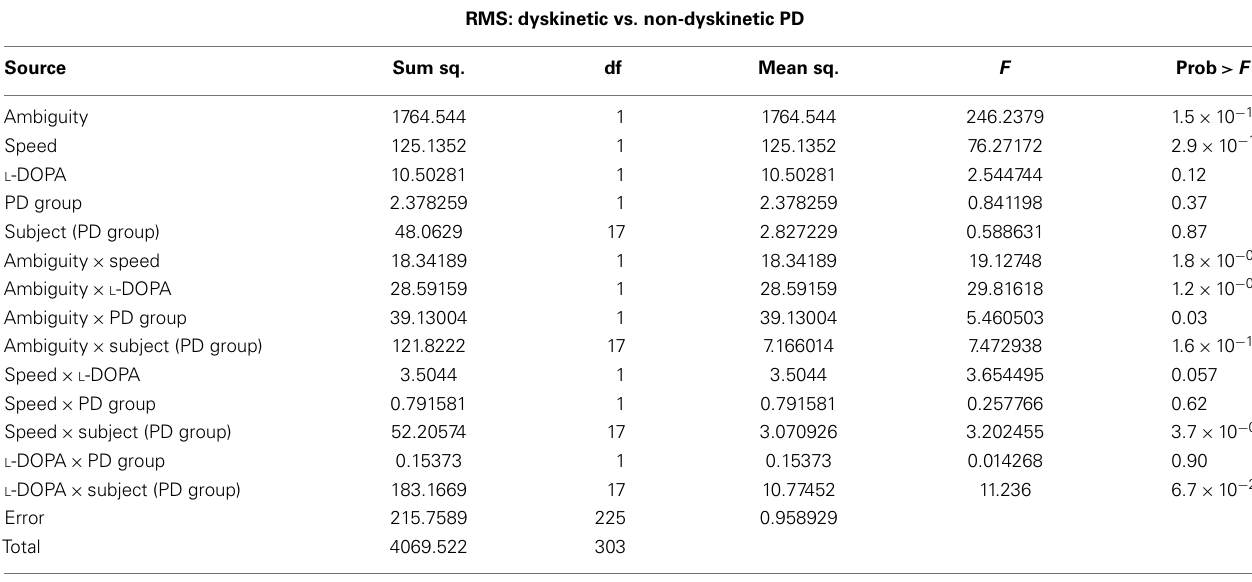
Table 2 | Mixed-model analysis of variance (ANOVA) table to assess different effects on overall RMS error in PD subjects . RMS: dyskinetic vs. non-dyskinetic